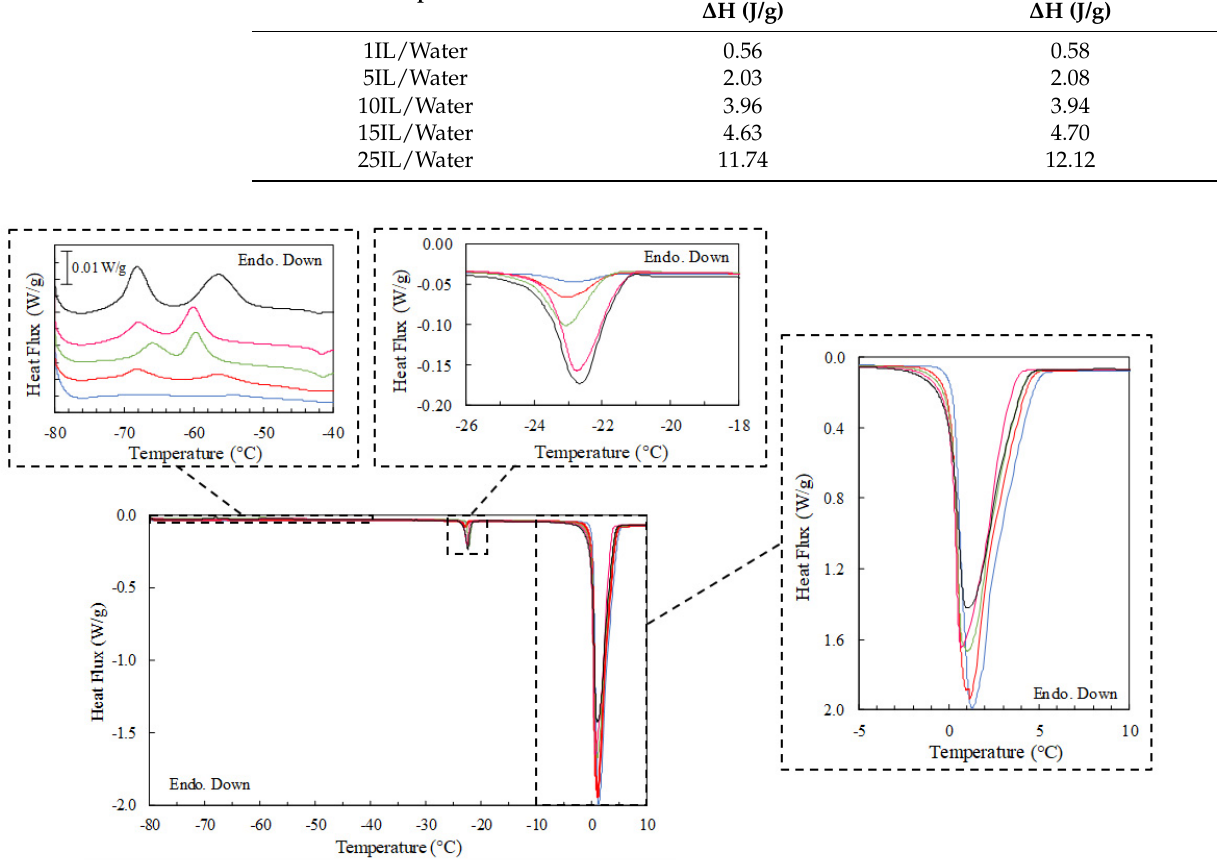
Figure 2. Heating DSC thermograms were obtained for the different IL/Water emulsions at 1 ◦ C/min. ( — ) 1IL/Water, ( — ) 5IL/Water, ( — ) 10IL/Water, ( — ) 15IL/Water, ( — ) 25IL/Water. Table 4. Accumulative enthalpies are associated with either endothermic or exothermic transitions of IL/Water mixtures in the temperature range between − 80 and − 15 °C.